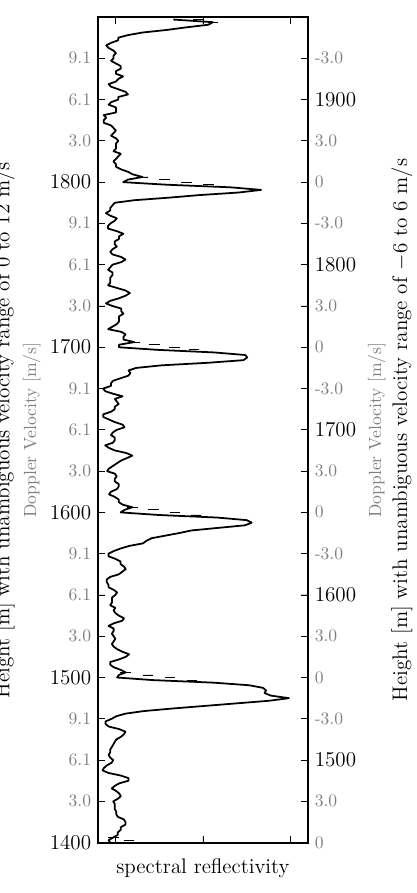
Fig. 4. Doppler spectra of several heights connected to each other as they are seen by a FMCW radar. The left scale shows the height lev- els (black) if an Nyquist Doppler velocity range of 0 to 12ms − 1 is chosen (grey scale). If, instead, the unambiguous Doppler velocity range is set to the Nyquist velocity ± 6ms − 1 (right, grey scale), the height of the peaks changes (right, black scale). The dashed lines indicate interpolations because of disturbances around 0ms − 1